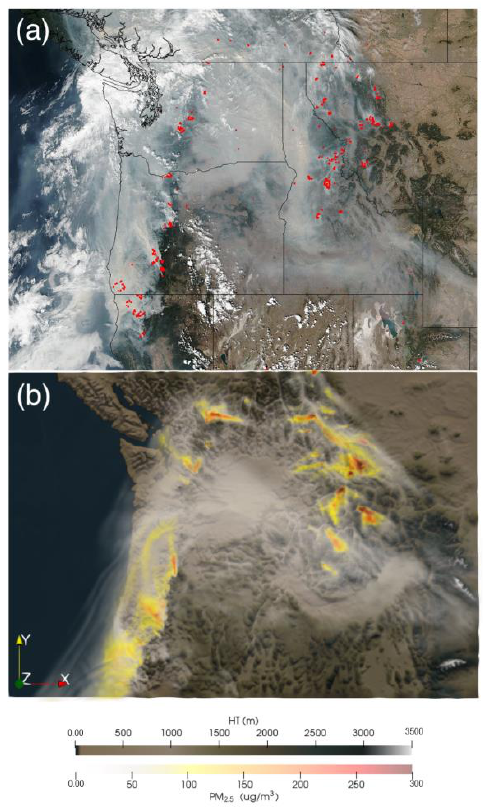
Figure 1. Fire hotspots and smoke over the PNW region on 9 / 5 / 2017. ( a ) satellite imagery detected by the NASA / NOAA Suomi NPP satellite at 20:36 UTC (13:36 PDT) (credit: Image by the NASA’s Land, Atmosphere Near real-time Capability for EOS (LANCE / EOSDIS) Rapid Response team). ( b ) WRF-CMAQ PM 2.5 simulation based on the SENS experiment with all sources. PNW: Pacific Northwest. NASA: National Aeronautics and Space Administration. NOAA: National Oceanic and Atmospheric Administration. NPP: National Polar-orbiting Partnership. WRF: Weather Research and Forecasting model. CMAQ: Community Multiscale Air Quality model. PM 2.5 : Fine particulate matter. SENS: sensitivity experiment. UTC: Coordinated Universal Time; PDT: Pacific Daylight Time; EOS: Earth Observing